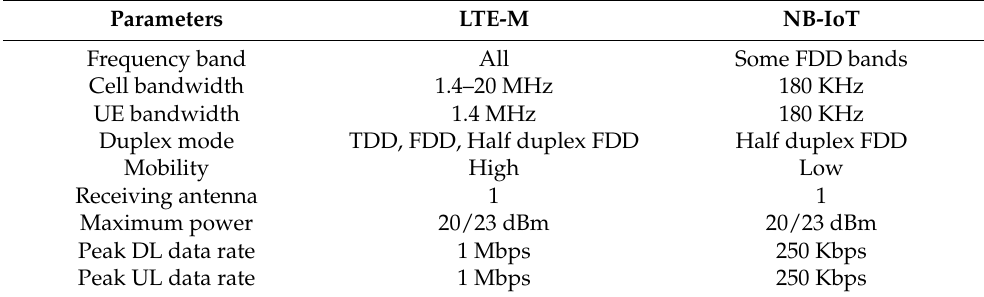
Table 1. Comparison of LTE-M with